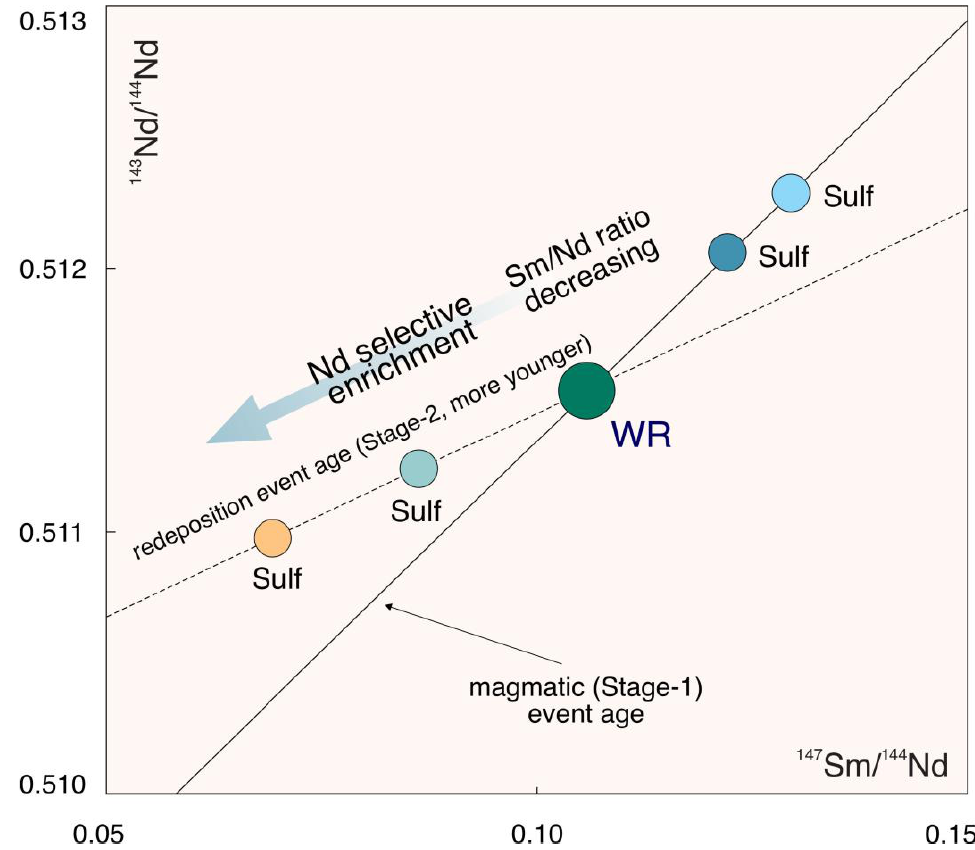
Figure 5. Chart demonstrating the effect of selective enrichment by neodymium in a hypothetical isochronous diagram. The process of relative Nd enrichment in comparison with Sm leads to a reduction in the Sm/Nd ratio for redeposited sulfides (Stage-2). In this case, the sulfide figurative points at an isochron often aim to the area of low 147 Sm/ 144 Nd ratio values. In this respect, the syngenetic ores form an isochron that corresponds to the age of the formation of the ore at the magmatic stage (Stage-1).